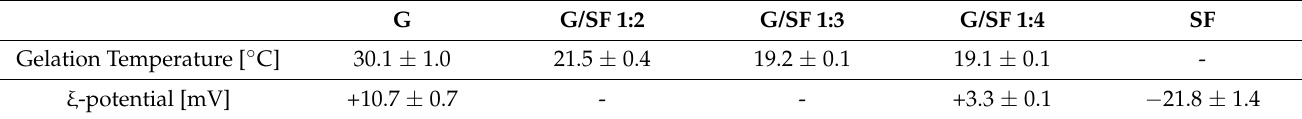
Table 1. The temperature of the sol–gel transition, ◦ C, derived at the intersection of the moduli (G (cid:48) and G (cid:48)(cid:48) ) is reported for the pure gelatin solution (G) and the three-volume ratios investigated by G:SF, namely 1:2, 1:3, 1:4. The average values along with the standard deviation are reported. The ξ -potential, mV, of the diluted solutions of pure gelatin (G), the chosen mixture composition (G/SF 1:4), and pure silk fibroin (SF) are reported as the mean values along with the standard deviation, calculated in four replicas.